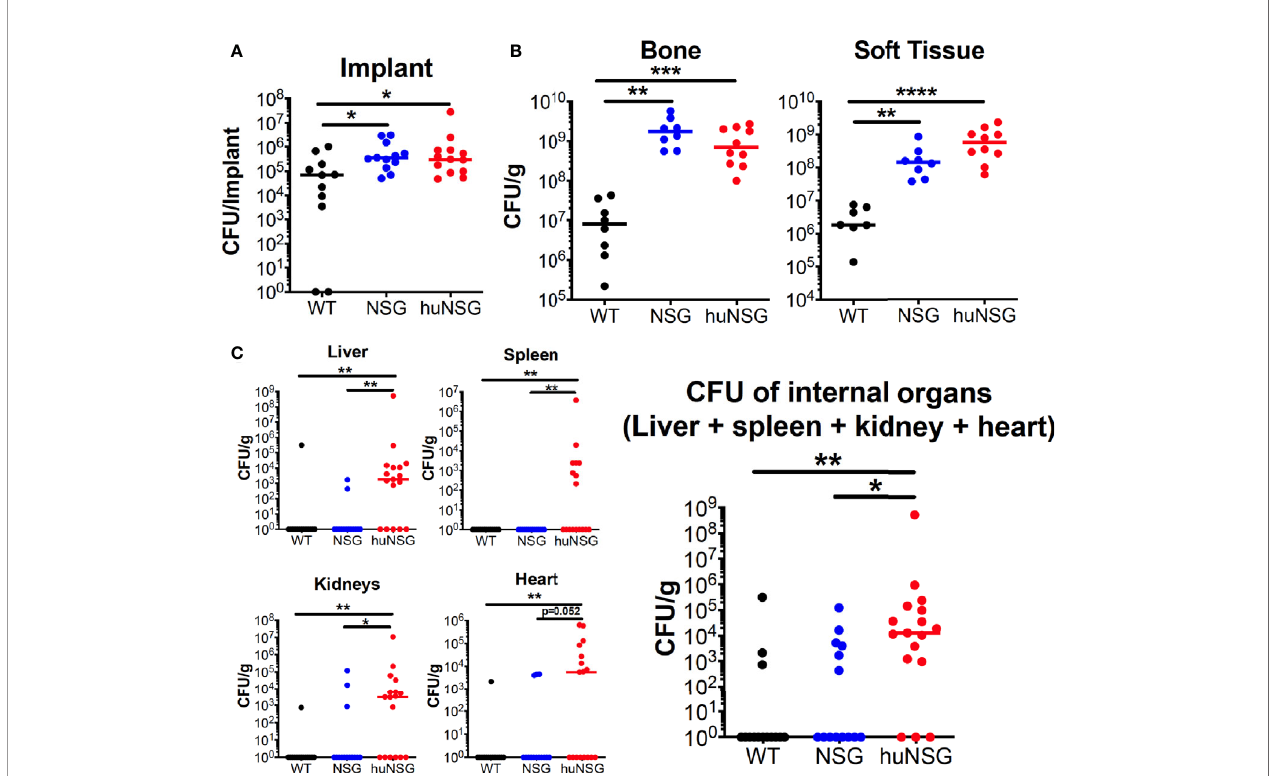
FIGURE 3 | Humanized mice exhibit increased bacterial load at the surgical site and sepsis during S. aureus implant-associated osteomyelitis. WT, NSG, and huNSG mice received MRSA infected trans-tibial implants and were euthanized on day 14 post-op to quantify CFUs from the (A) implant, (B) tibia and adjacent soft tissue, and (C) internal organs. The data are presented for each mouse with mean +/- SD for the Group (n = 14-17, * p < 0.05, ** p < 0.01, *** p < 0.001, one-way